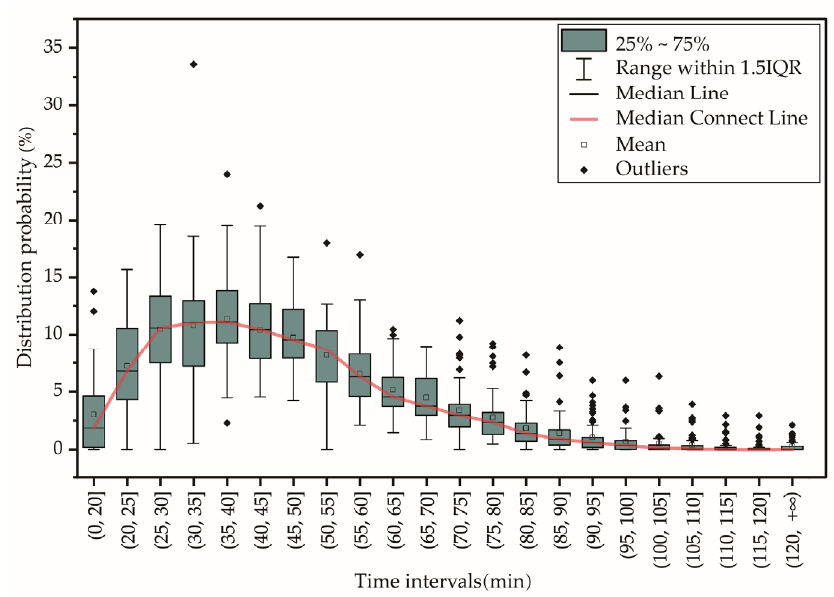
Figure 6. Probability distribution of park visitors with time intervals.